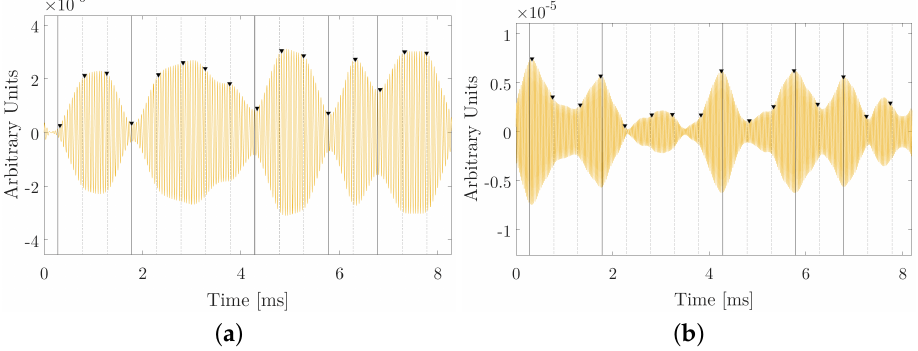
Figure 6. Correlation analysis for FSK. ( a ) Cross-correlations between the received signal and the expected 1 bit de 10 kHz, ( b ) and between the received signal and the expected 0 bit 20 kHz a 500 µ s duration per